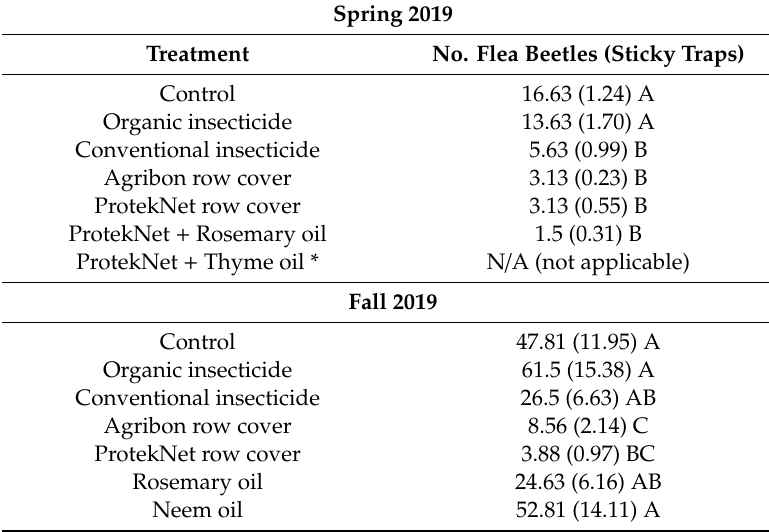
Table 2. E ff ects of treatments on the number of flea beetles caught by yellow sticky traps (mean and standard